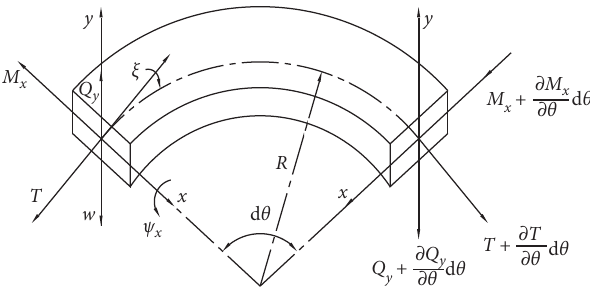
Figure 1: Schematic of out-of-plane vibration of a curved